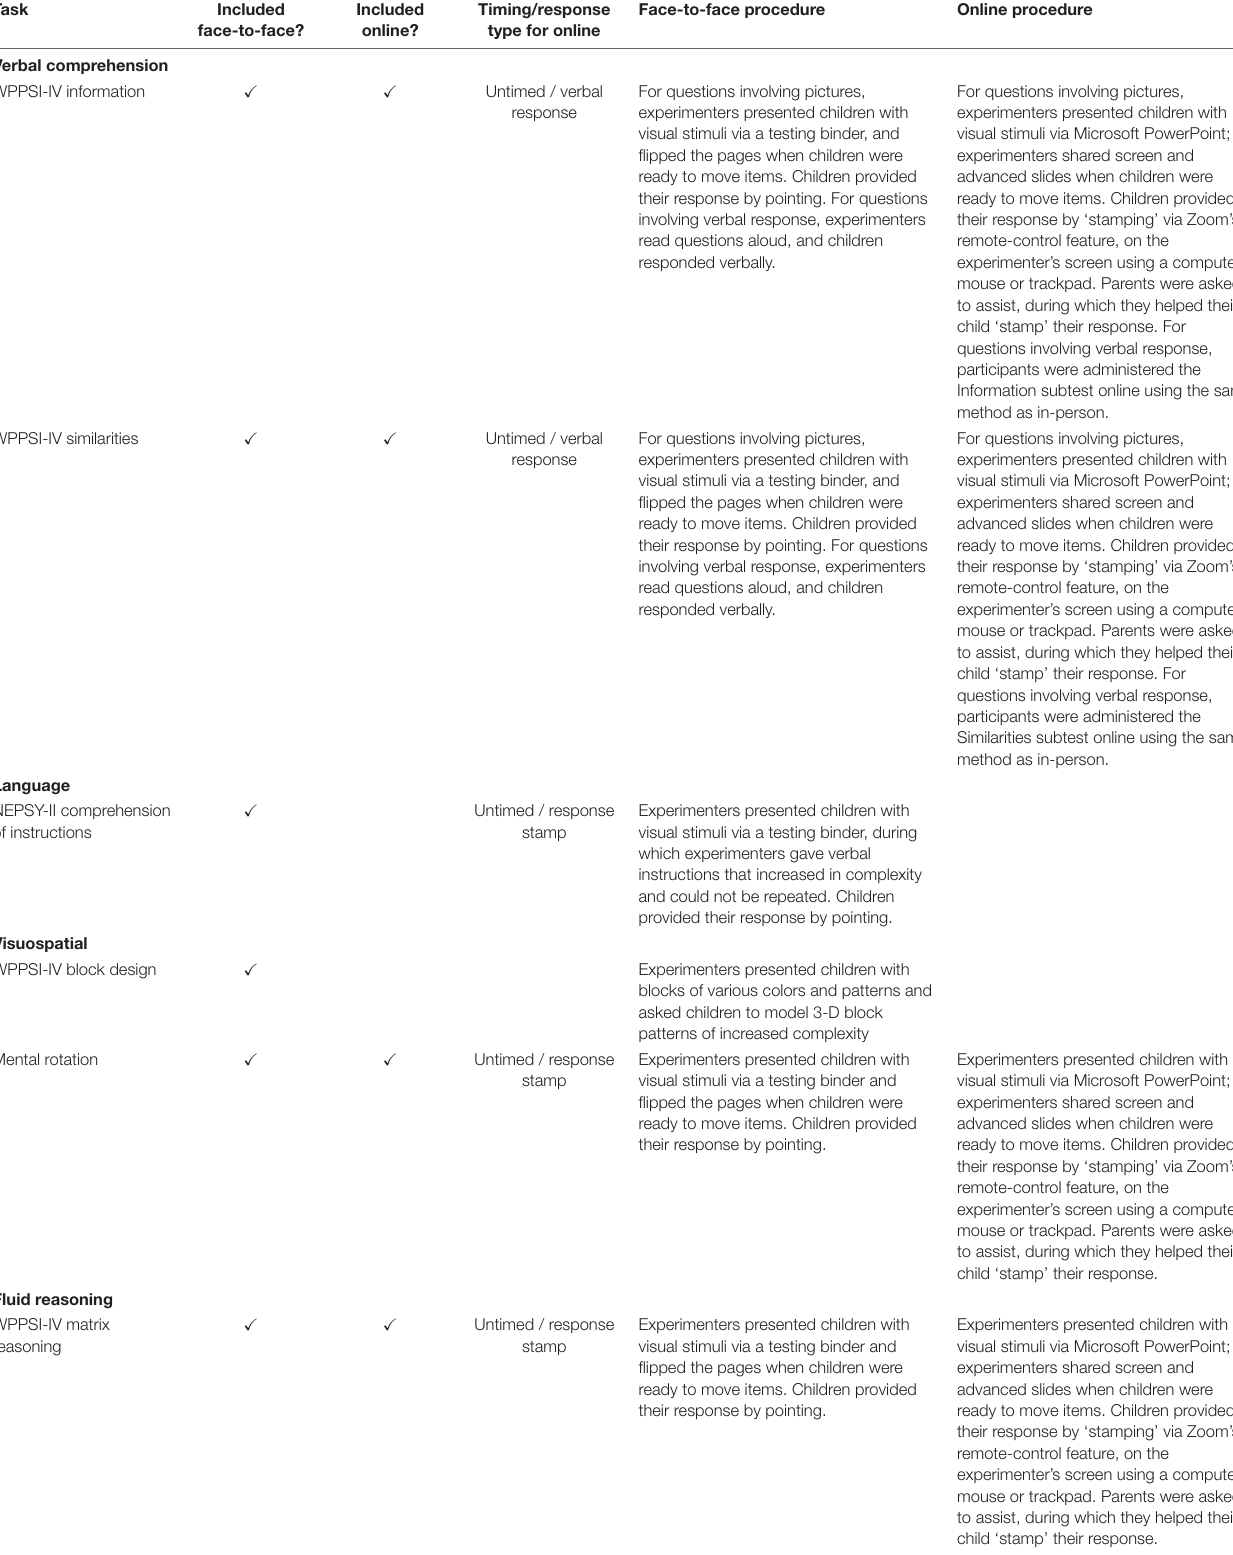
TABLE 2 | Task descriptions for face-to-face and online procedures.